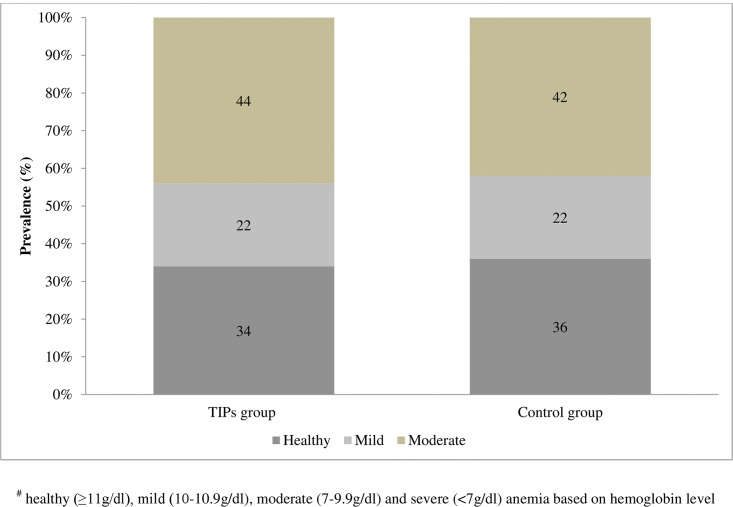
Percentage prevalence of anemia in both the study groups before the TIPs intervention.Hemoglobin level cut-offs: healthy (≥11g/dl), mild (10–10.9g/dl), moderate (7–9.9g/dl) and severe (<7g/dl) anemia